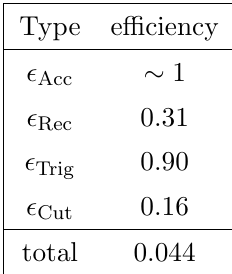
Table 2 . Values of the e(cid:14)ciencies calculated/used in this